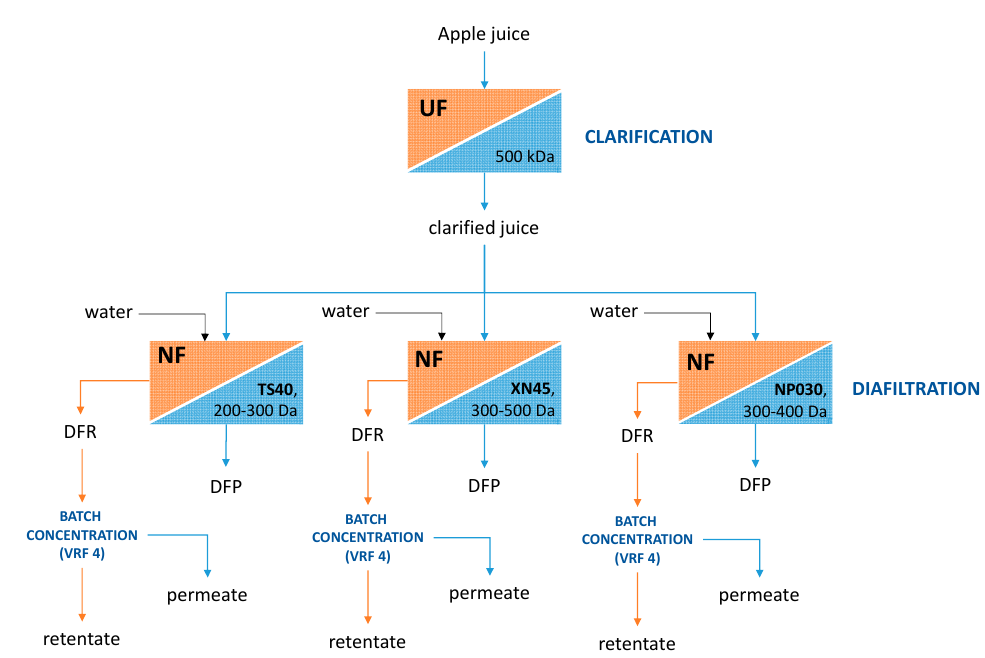
Figure 1. Flow chart of the experimental set-up (UF, ultrafiltration; NF, nanofiltration; DFR, diafil- trated retentate; DFP, diafiltrated permeate).